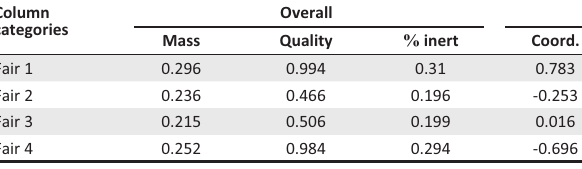
FIGURE 1-A2: Descriptive